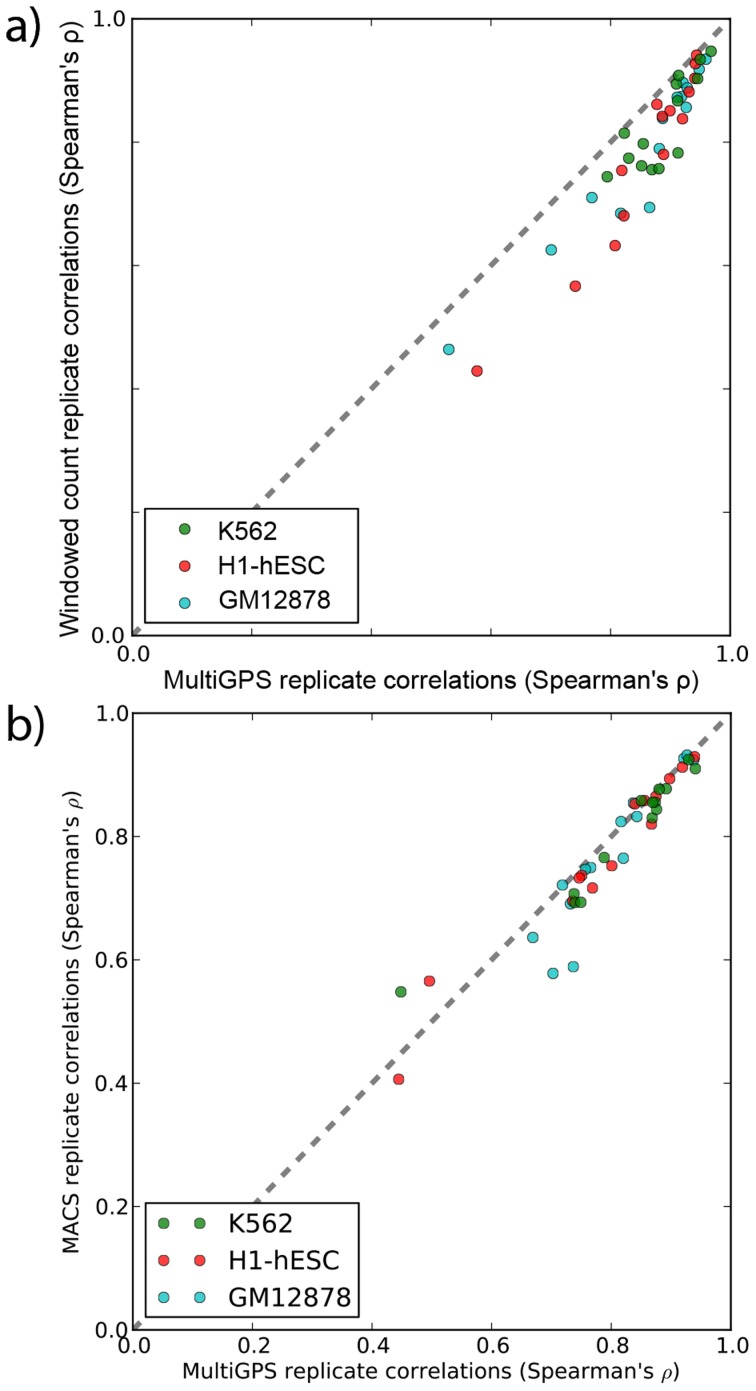
MultiGPS probabilistic ChIP-enrichment estimates improve binding site quantification consistency across replicates.MultiGPS was used to identify binding sites on 14 ENCODE transcription factor ChIP-seq experiments in three Tier 1 cell types. Binding site strengths were quantified with MultiGPS's probabilistic model, incorporating an integrated noise model and read sharing among nearby binding sites, and either: a) windowed counts, which sum up reads in a 400 bp window centered on the MultiGPS predicted binding location; or b) peak heights defined by MACS. MultiGPS produces more replicable quantifications for all examined factors in a), and most in b).